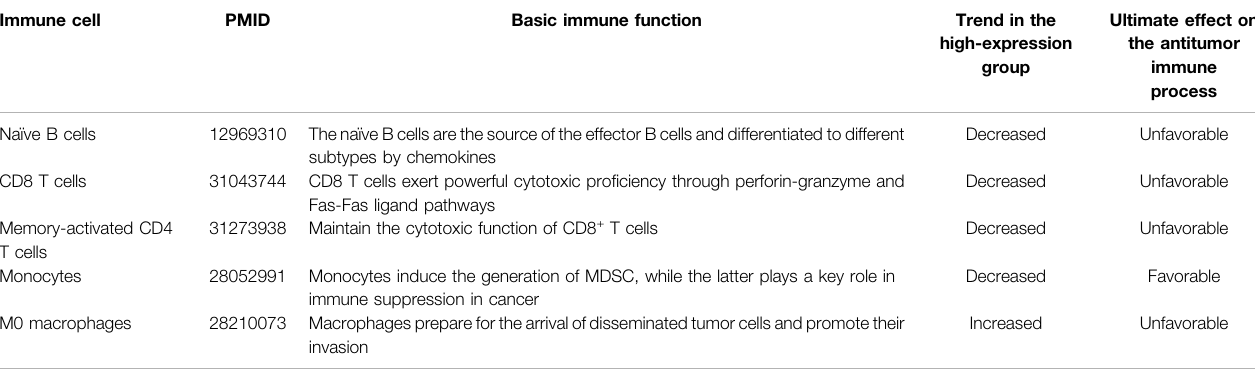
TABLE 3 | The effects of SLC1A5 on the in fi ltration levels of the immune cells. Immune cell